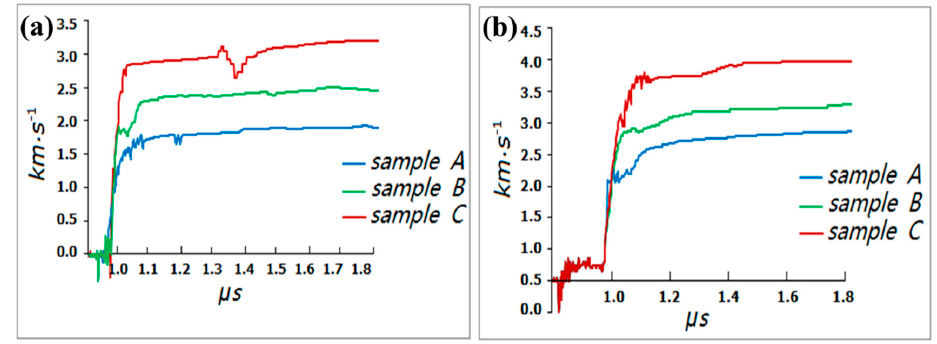
Figure 7. ( a ) The spectrum diagram of the flyer velocity, and the Fourier transform velocity spec- trum (2.0 kV) of ( b ) Sample A, ( c ) Sample B, and ( d ) Sample C.